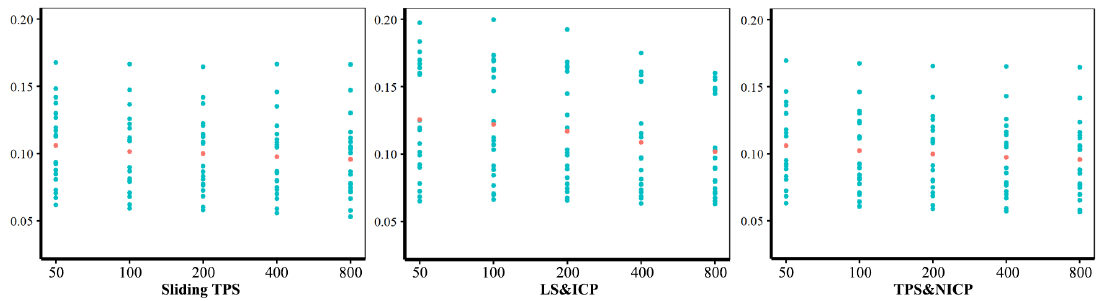
Figure 6. Vectors of Procrustes distances between each individual and the mean computed for each semilandmarking approach using different densities of semilandmarks. Cyan points represent Procrustes distances between every specimen and the Procrustes mean shape and red points represent the average value of the Procrustes distance vector.